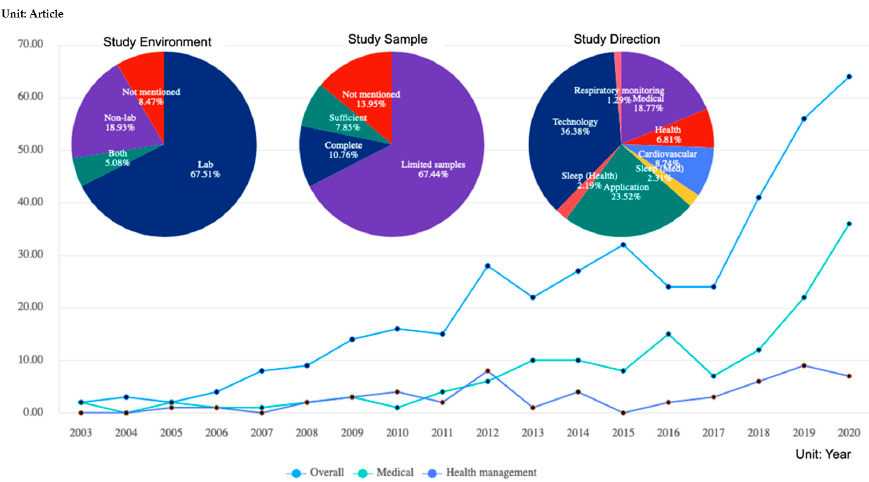
Figure 6. Annual statistics of publications and results of classification (top 10).